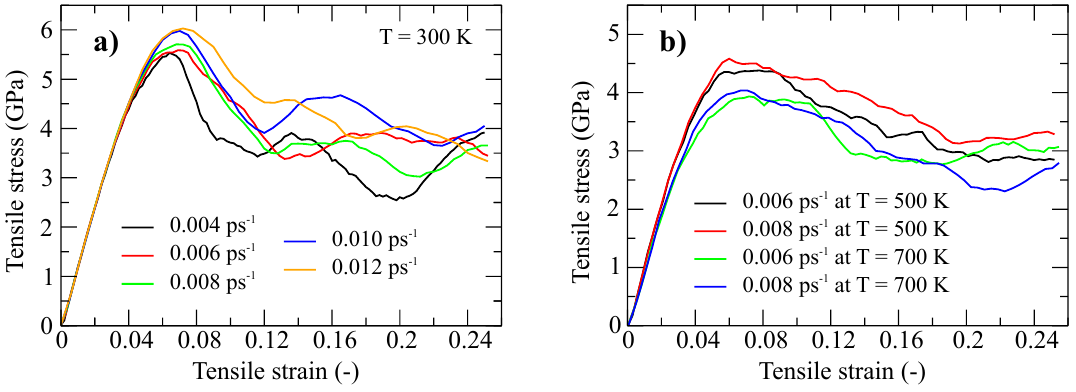
Figure 4. Stress-strain curves at ( a ) different strain rates and ( b )